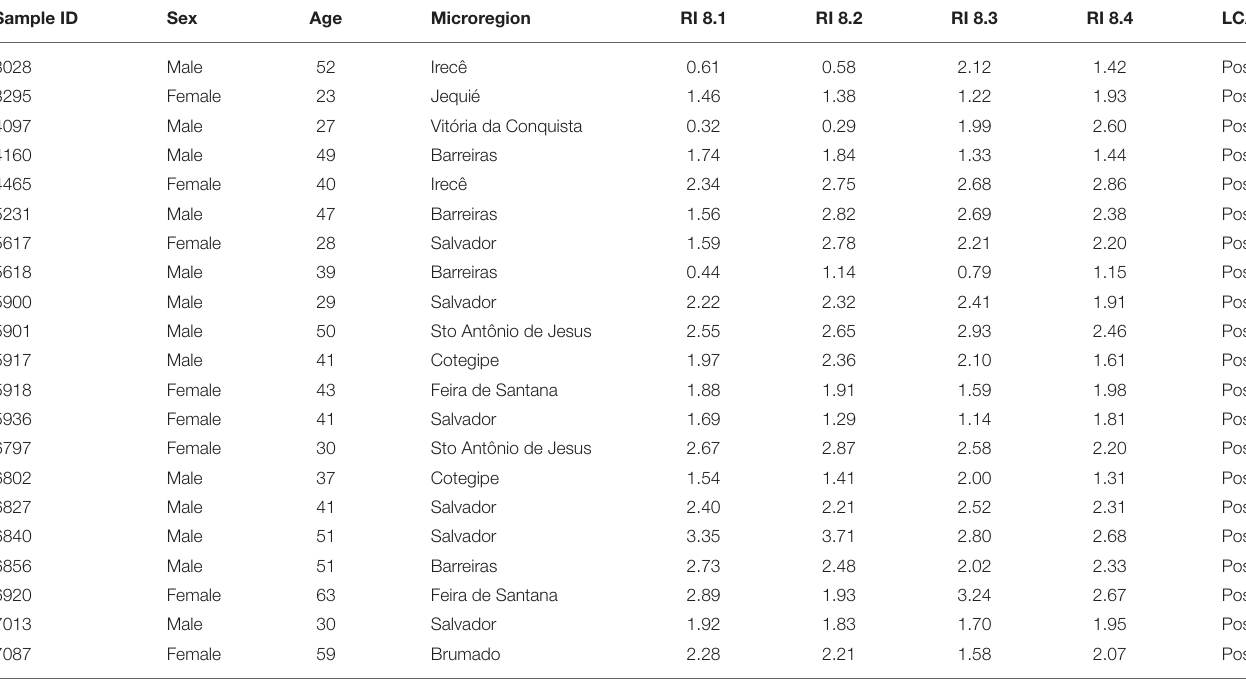
TABLE 2 | Data stratified by sociodemographic variables and reactivity indices for chimeric IBMP antigens from all 21 blood donors classified as T. cruzi -positive by latent class analysis. Sample